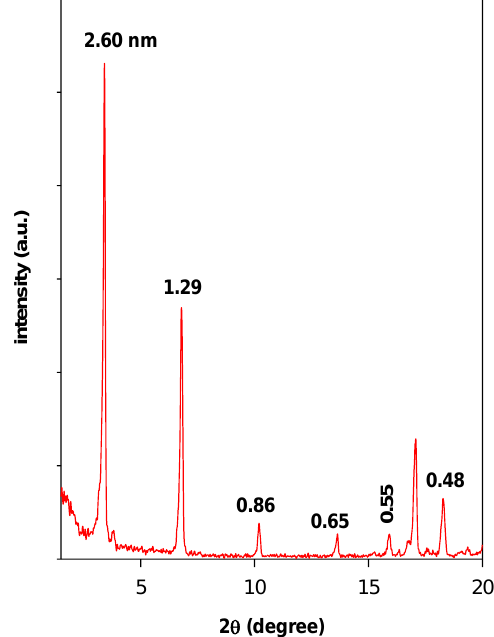
Figure 11. Powder XRD pattern of the starting C16TMABr salt.